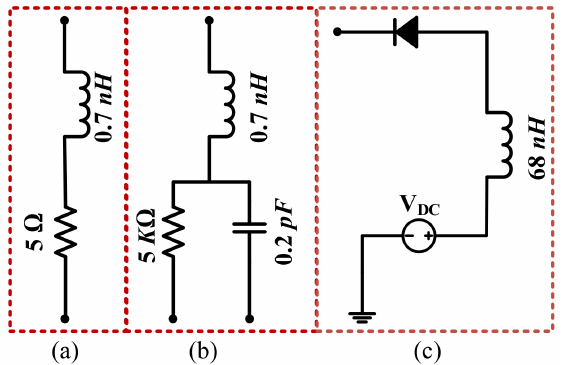
Figure 5. Equivalent model of diode for ( a ) ON-state, ( b ) OFF-state, and ( c ) biasing